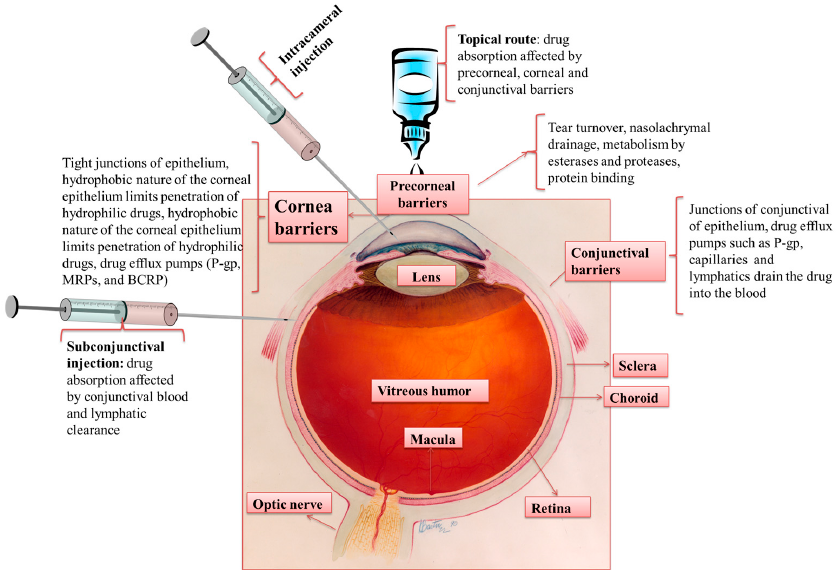
Figure 1. Routes of administration for anterior segment drug delivery, ocular tissue barriers and clearance mechanisms that prevent drug absorption into the eye. Modified from: Credit: National Eye Institute, National Institutes of Health (Ref#: NEA04).